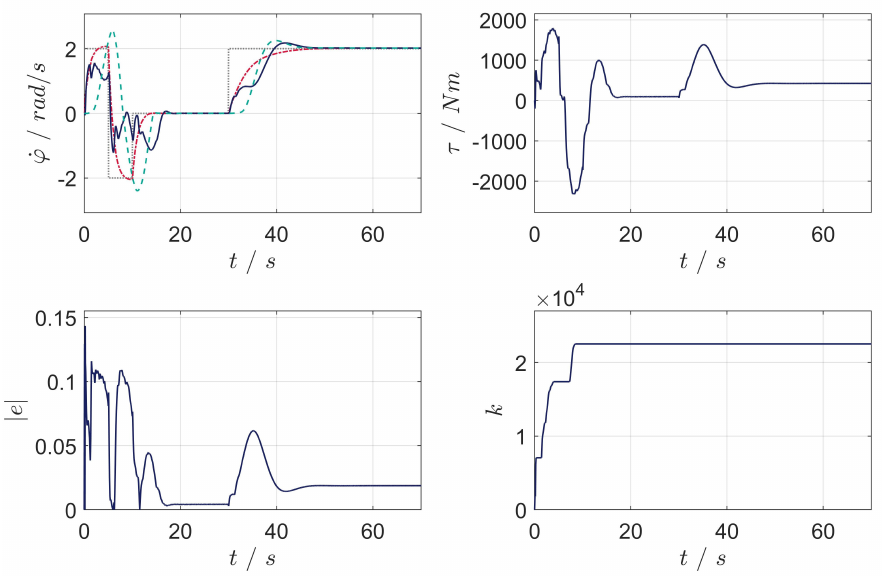
Figure 11. Transient responses of the closed-loop system. Adaptation and angular velocity reference tracking: ˙ ϕ 0 (solid blue), ˙ ϕ L (dashed green), ˜ y (dash-dot red) and r (dotted gray).